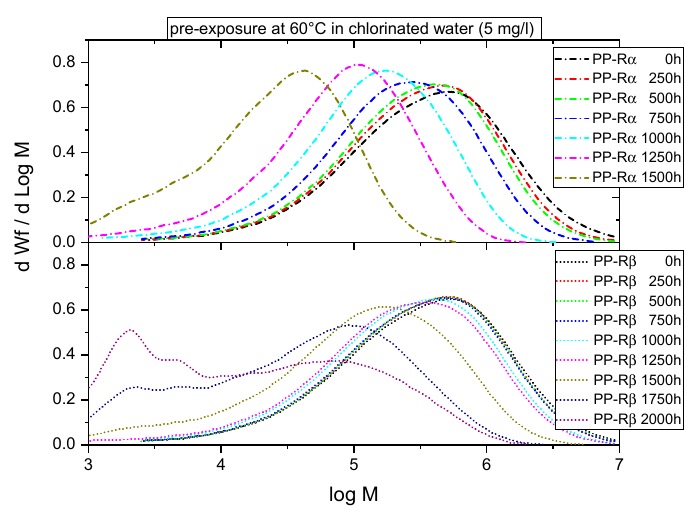
Figure 4. Time-dependent molar mass distribution for the two PP-R grades.